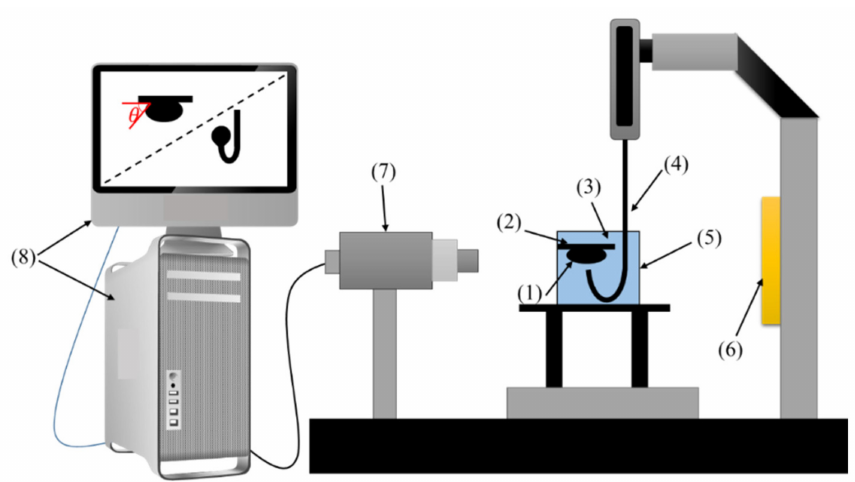
Figure 6. Schematic of the setup for interfacial tension IFT) and contact angle tests: (1) oil droplet, (2) rock section, (3) aqueous solution, (4) needle, (5) cell, (6) light source, (7) CCD camera, (8) processor.